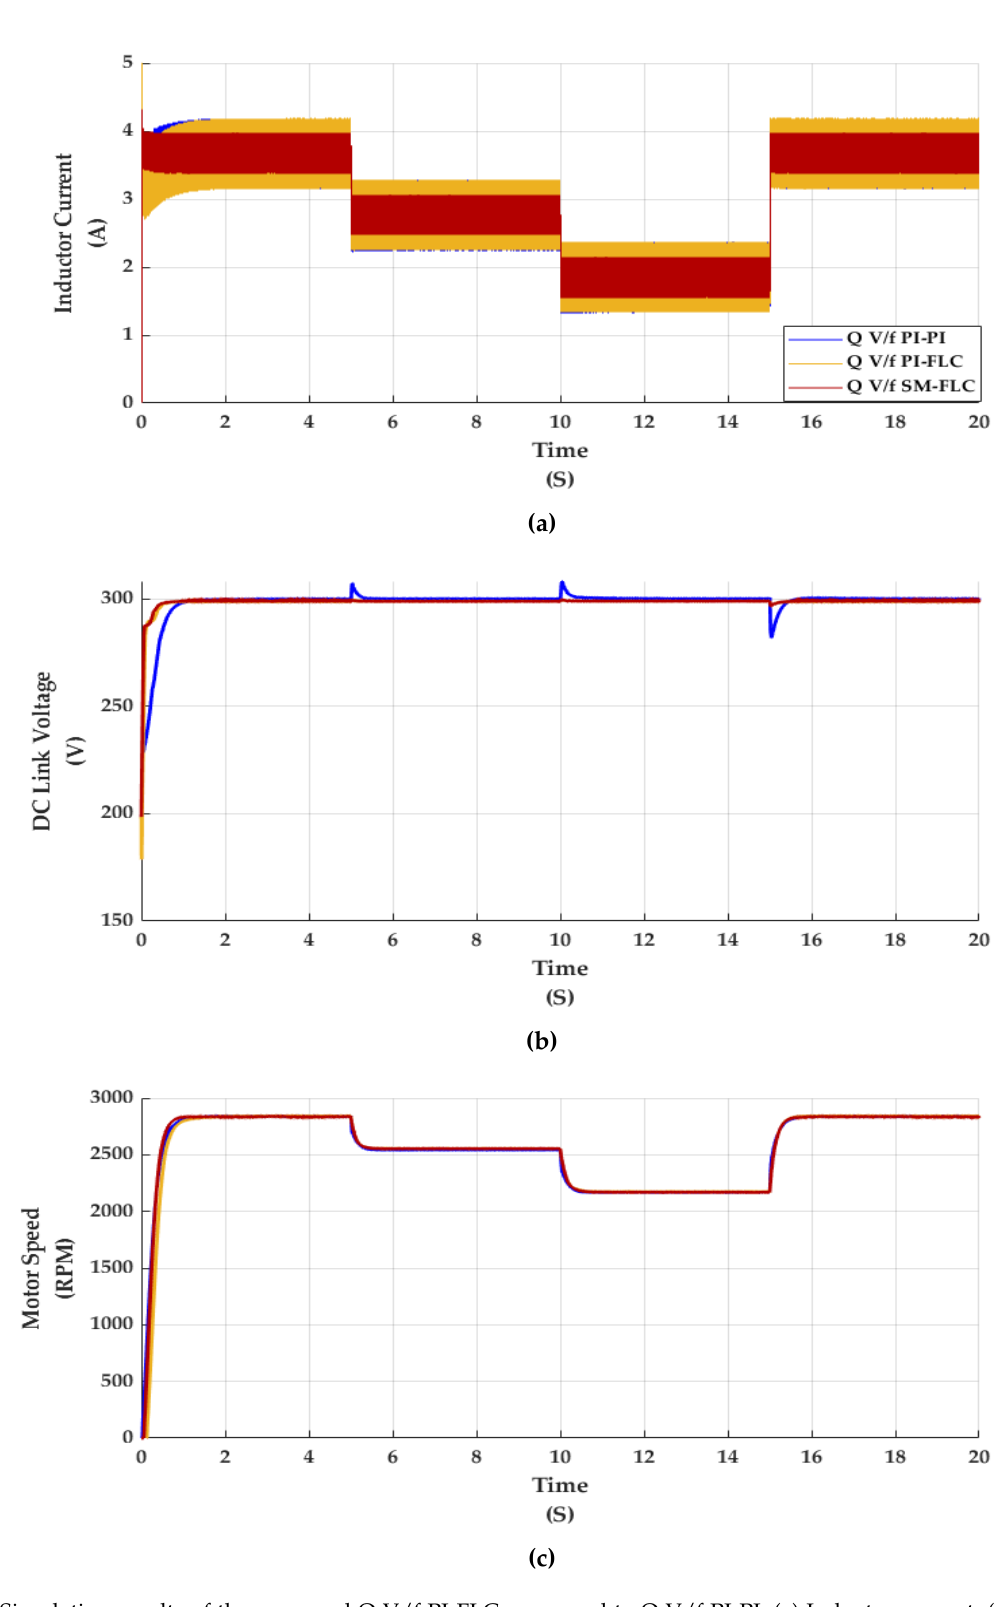
Figure 8. Simulation results of the proposed Q V/f PI-FLC compared to Q V/f PI-PI: ( a ) Inductor current; ( b ) DC link voltage; ( c ) Motor speed.